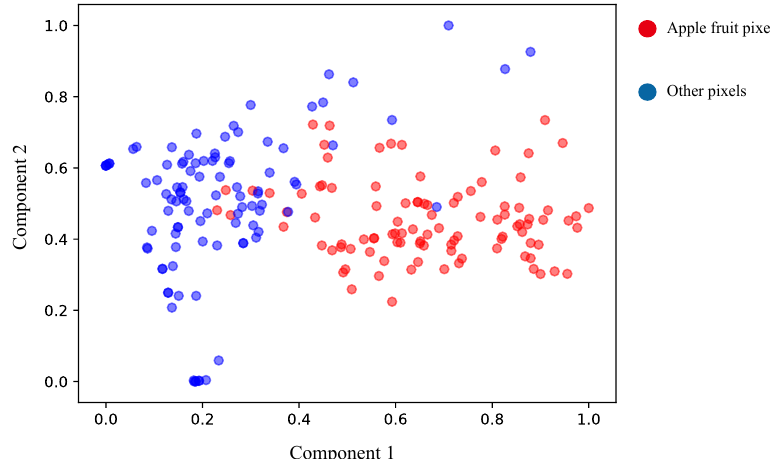
Figure 8. The scatter diagram of apple fruit pixels and other pixels in the dimension reducing principal component space.